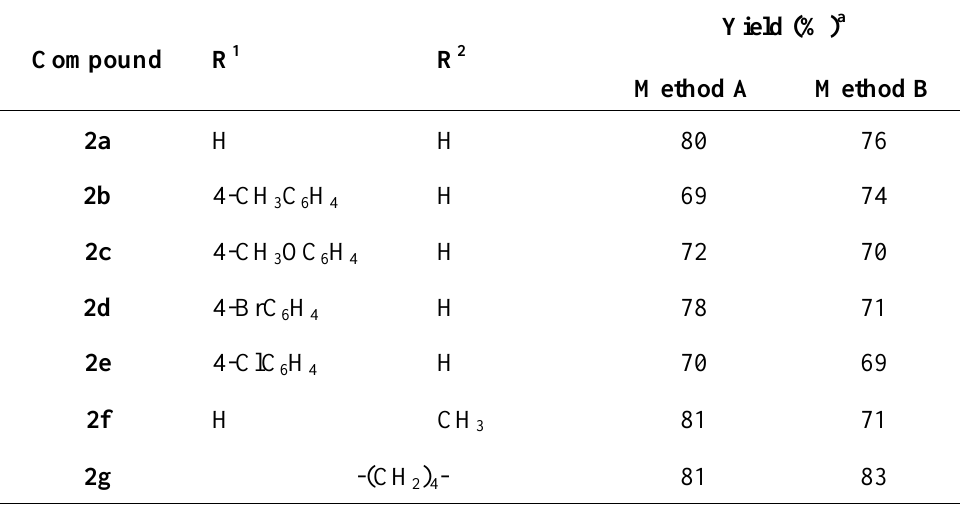
Table 1. α -Azido ketones 2 prepared according to Scheme